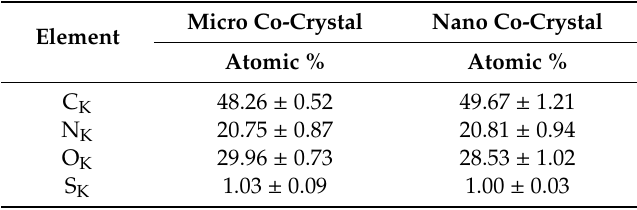
Table 2. Elemental composition of the micro and nano co-crystal.